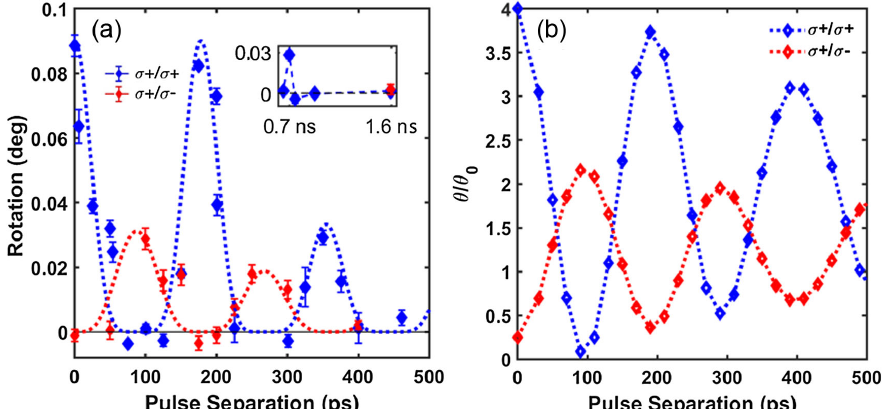
FIG. 3. Detailed time dependence of skyrmion crystal rotation. (a) Double pulse timed experiments showing the rotation of the skyrmion crystal observed as a function of the delay between the two pump pulses. The pulses either have both σ þ polarization (blue points) or a sequence of σ þ = σ − polarization (red points). For the blue points, we use pulses of equal amplitude (each with 1 . 1 mJ = cm 2 ) and observe a coherent oscillation in the amplitude of rotation with a period of 175 ps that damps out progressively over a nanosecond. For the case of σ þ = σ − polarization, the second pulse of σ − polarization has half the amplitude ( 0 . 6 mJ = cm 2 ) of the first one ( 1 . 1 mJ = cm 2 with σ þ polarization). Here, we observe rotation with approximately half the amplitude out of phase with the previous oscillation. The blue and red dashed lines are a guide for the eye. Error bars (95% confidence intervals) are within the markers used. (b) Theoretical prediction of the rotation angle θ = θ 0 for such pulse sequences in a clean system where θ 0 is the rotation angle for a single pulse. The theory is based on the calculation of rotational torques arising from breathing-mode oscillations; see Supplemental Material